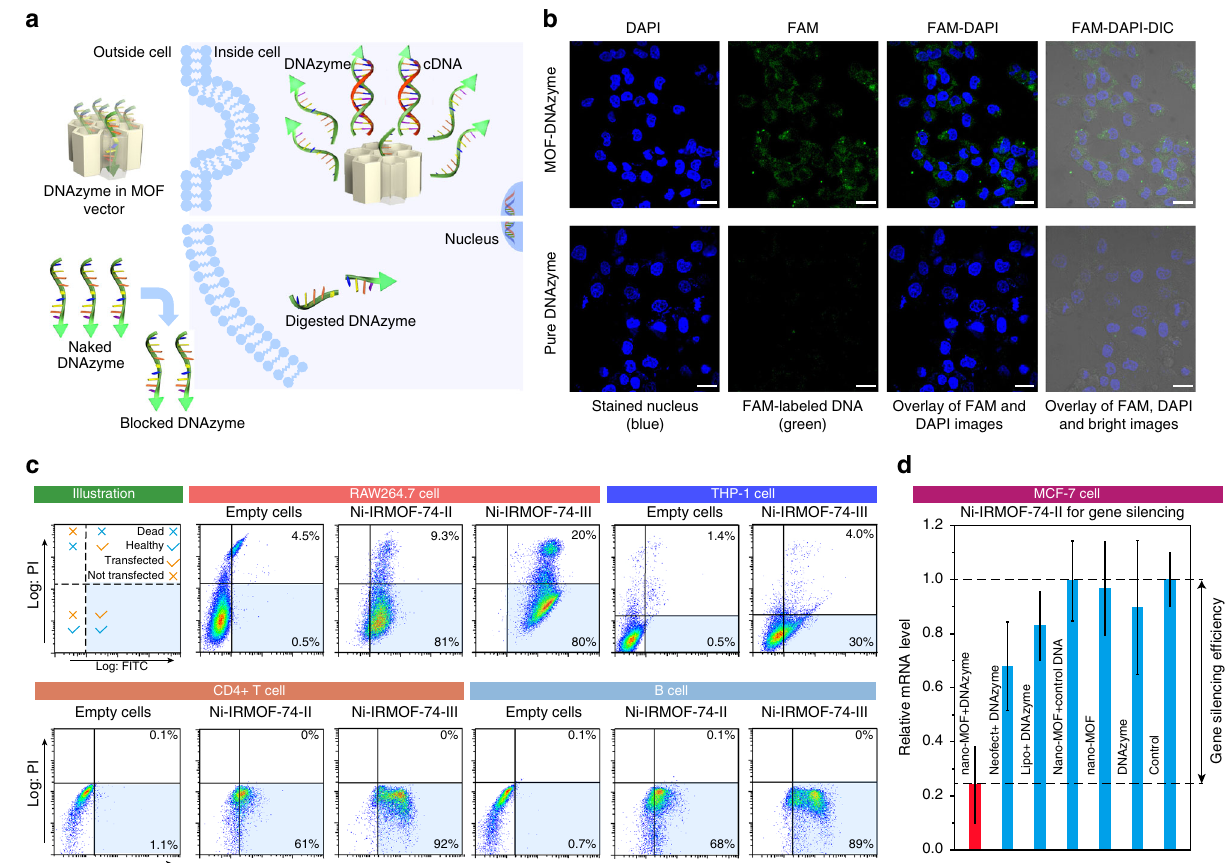
Fig. 4 Effective intracellular delivery and gene silencing. a Illustration of intracellular delivery of ssDNA with and without MOF as vectors, above and below, respectively. b Comparison of the intracellular delivery ef fi ciency of ssDNA with and without MOFs by confocal Laser Scanning Microscopy in MCF-7 cells. Nuclei were stained with DAPI (blue), FAM-labeled ssDNA in green, scale bar: 20 μ m. c Transfection ef fi ciency and toxicity of Ni-IRMOF-74-II and -III re fl ected in Flow cytometry in mouse immune cell (RAW264.7), human immune cell (THP-1), CD4 + T cell, and B cell. d Gene silencing ef fi ciency of the DNAzyme carried by Ni-IRMOF-74-II, Lipo, and Neofect in MCF-7 cells ( n = 3 technical replicates; bars represent mean ±